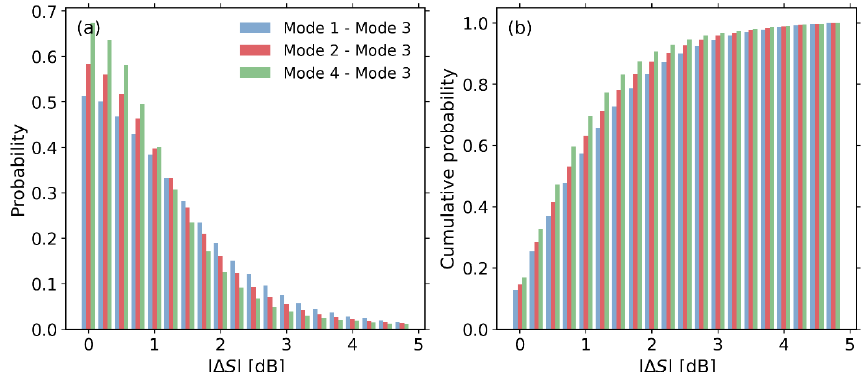
Figure A1. (a) Probability density and (b) cumulative distribution of the spectral power ratio of meteorological signals between different modes at Ku